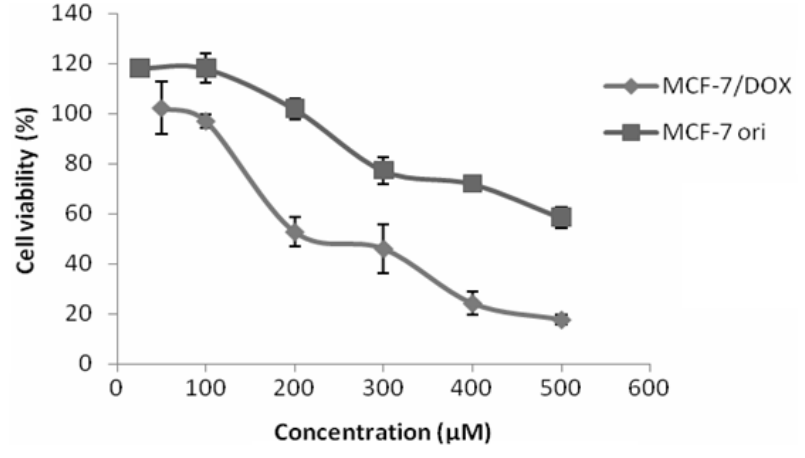
Figure 1. Hesperetin increased sensitivity of MCF/7Dox cells to doxorubicin. Cells were seeded in 96-well plates at a density of 10x103cells per well for 24h, and then treated with various concentrations of hesperetin for 24h. Cell viability was then determined by adding MTT reagent and measuring the absorbance at 595nm as described in ‘Materials and methods’. IC50 was determined from a plot of percent cell viability from untreated control cells versus concentration. All results are expressed as mean ± SD from three independent